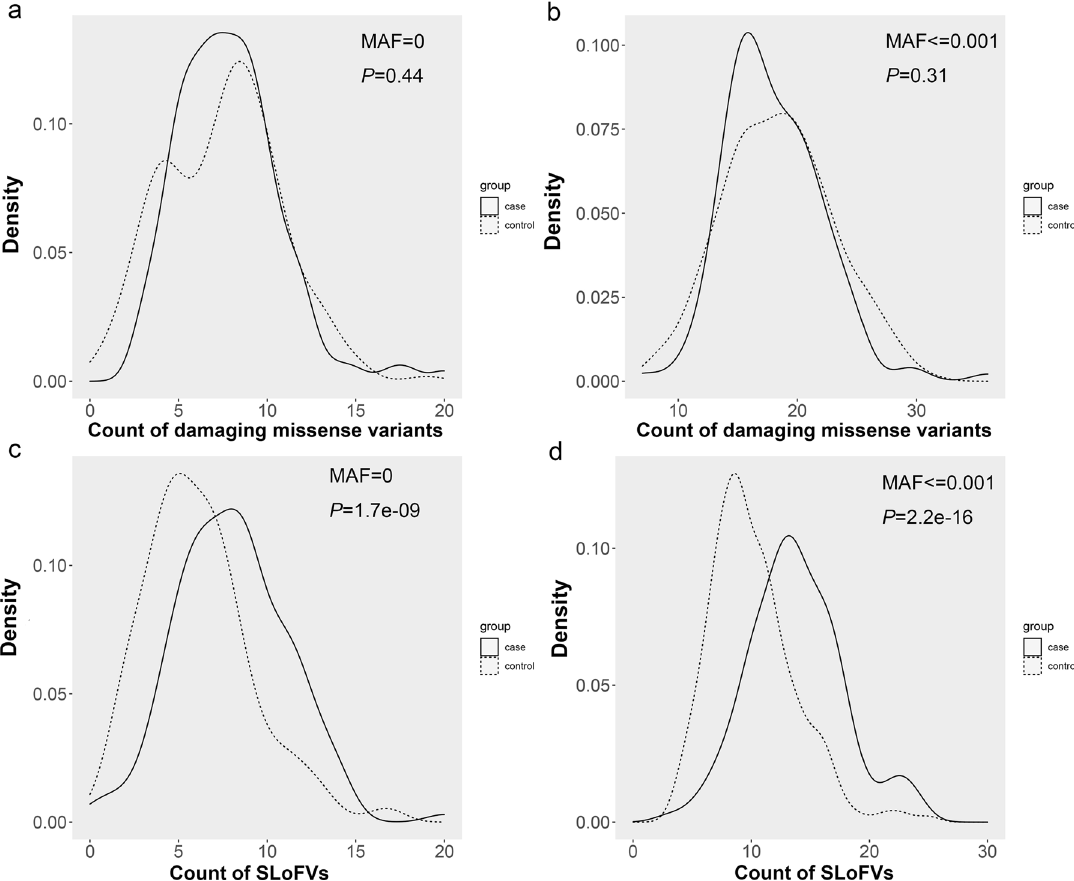
Fig. 3 Accumulation of rare singleton deleterious variants in fetal CNS cohort. Distribution of rare singleton deleterious missense variants of a MAF = 0; b MAF ≤ 0.01. Accumulation of rare SLoFVs of c MAF = 0, with median of 8 in cases (solid line) and 6 in controls (dashed line) with P = 1.7 × 10 − 9 by two-sided Wilcoxon test and d MAF ≤ 0.01, with median of 13.5 in cases and 9 in controls with P = 2.2 × 10 − 16 by two- sided Wilcoxon test. SLoFVs singleton loss-of-function